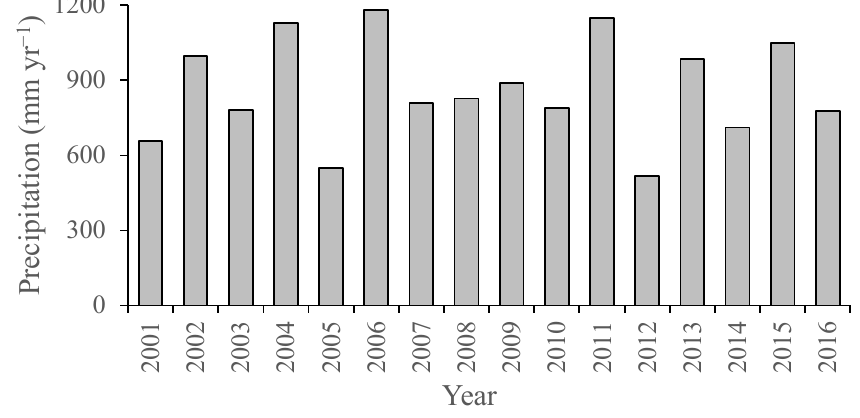
Figure 2. Annual average precipitation.